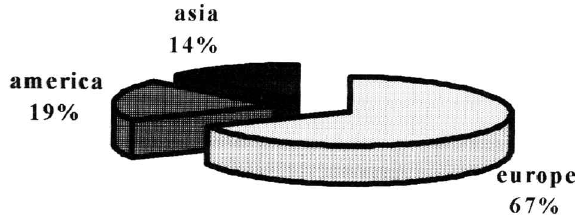
FIG. 1. Distribution of submitted papers in the first decade of publication.